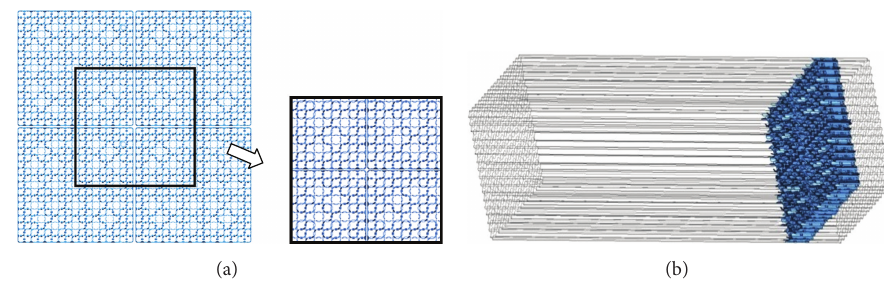
Figure 2: Computational domain and mesh.